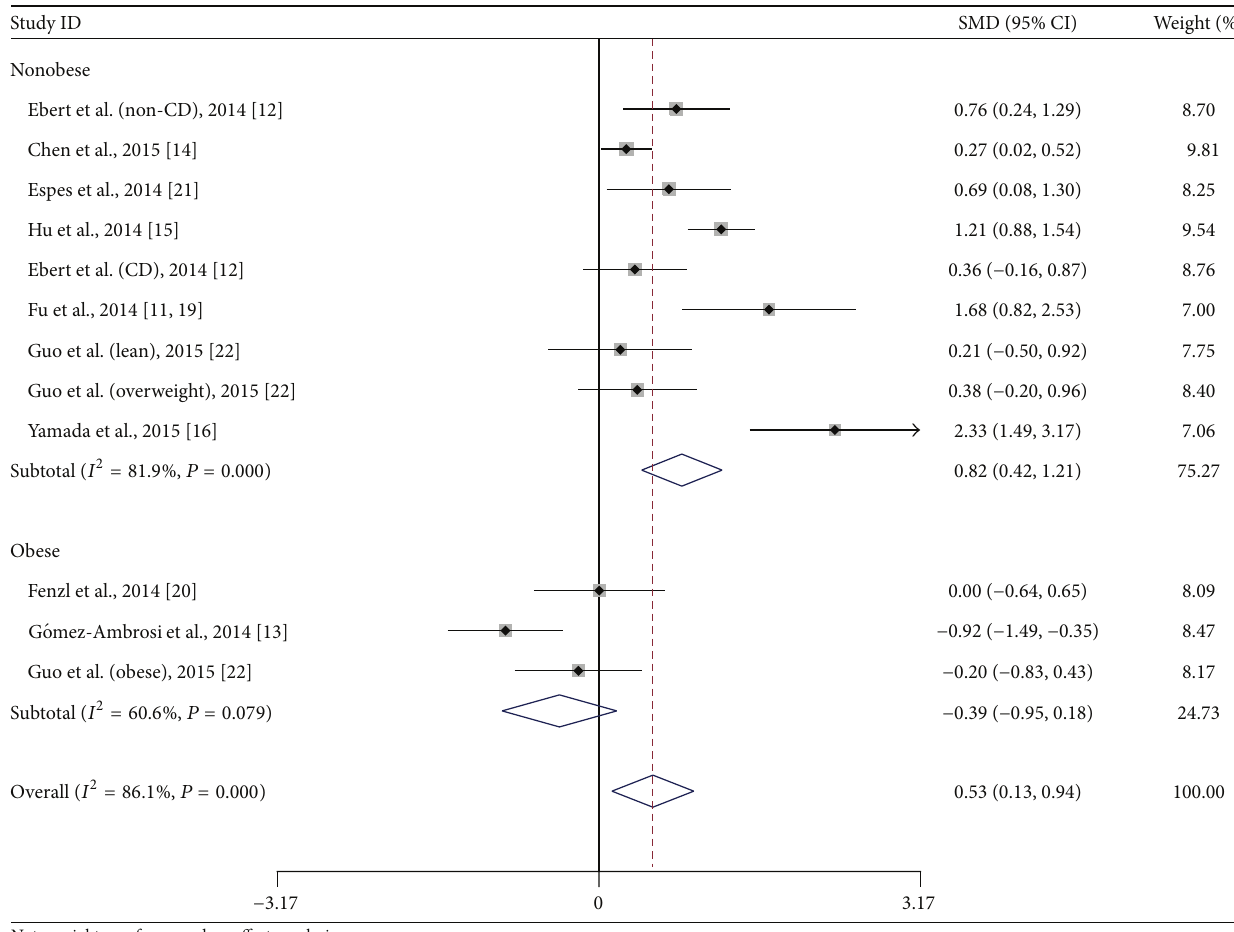
Figure 2: Subgroup analysis of circulating betatrophin level in T2DM or nondiabetic patients based on the body mass. CD: chronic hemodialysis; CI: confidential interval; SMD: standard mean difference. Test for subgroup differences: 𝜒 2 = 11.6 ; df = 1 ; 𝑃 = 0.0007 ; 𝐼 2 = 91.4